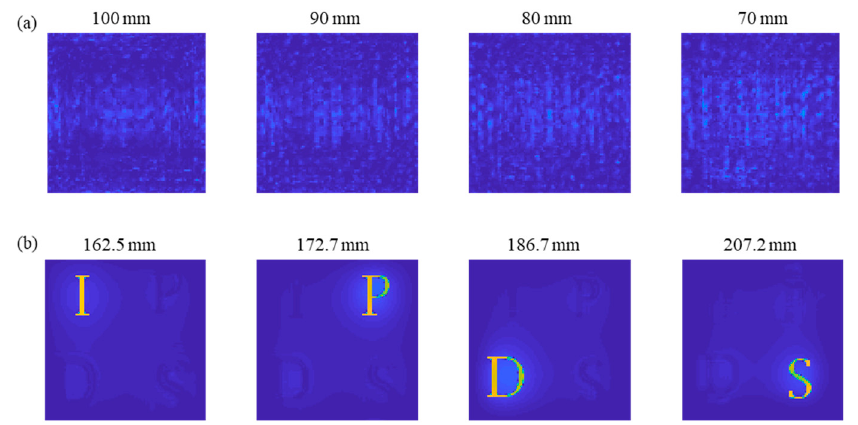
Figure 8. Compressive holographic sectioning of the hologram ( a ) for the depth information (100 mm, 90 mm, 80 mm, and 70 mm). without distortion compensation, and ( b ) with distortion compensation (162.5 mm, 172.7 mm, 186.7 mm, and 207.2 mm). (Each column from the left presents the result of object ‘I’, ‘P’, ‘D’, and ‘S’).